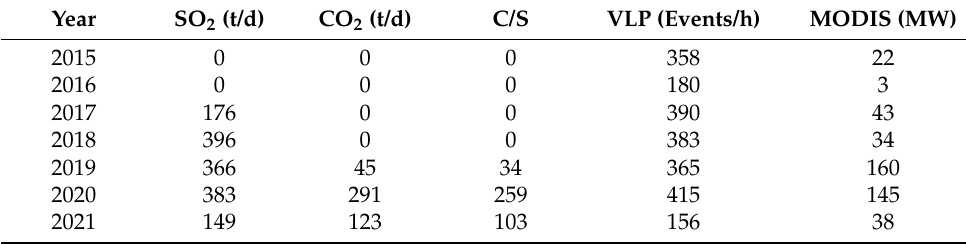
Table 4. Number of parameter–value pairs for the LGS dataset (both weekly and